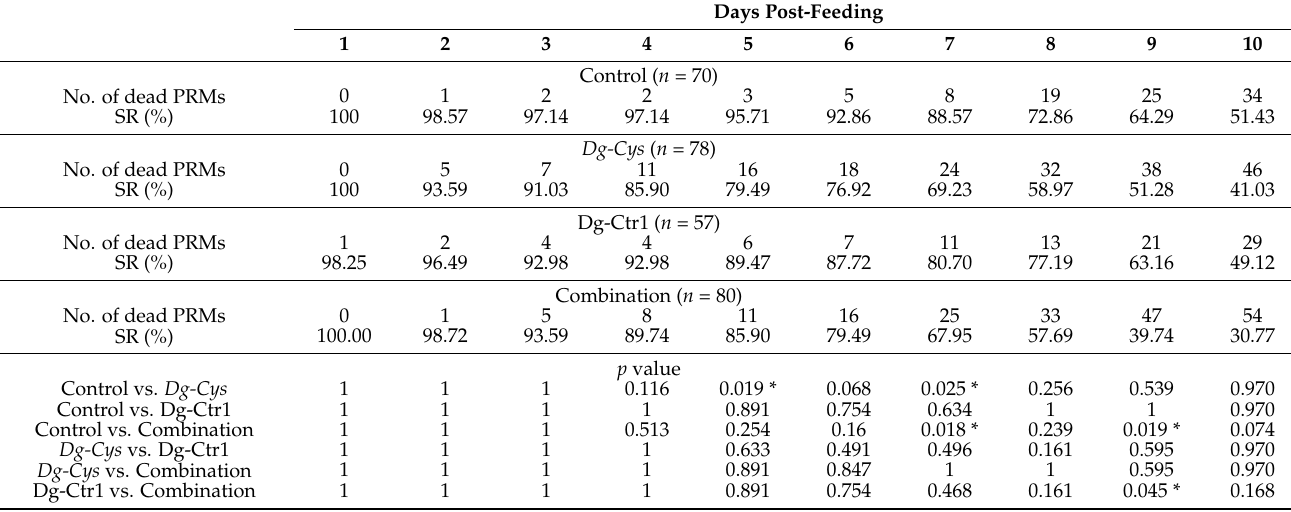
Table 3. Summary of the acaricidal effects of combined immune plasmas on adult mites ( Dg-Cys and Dg-Ctr1).